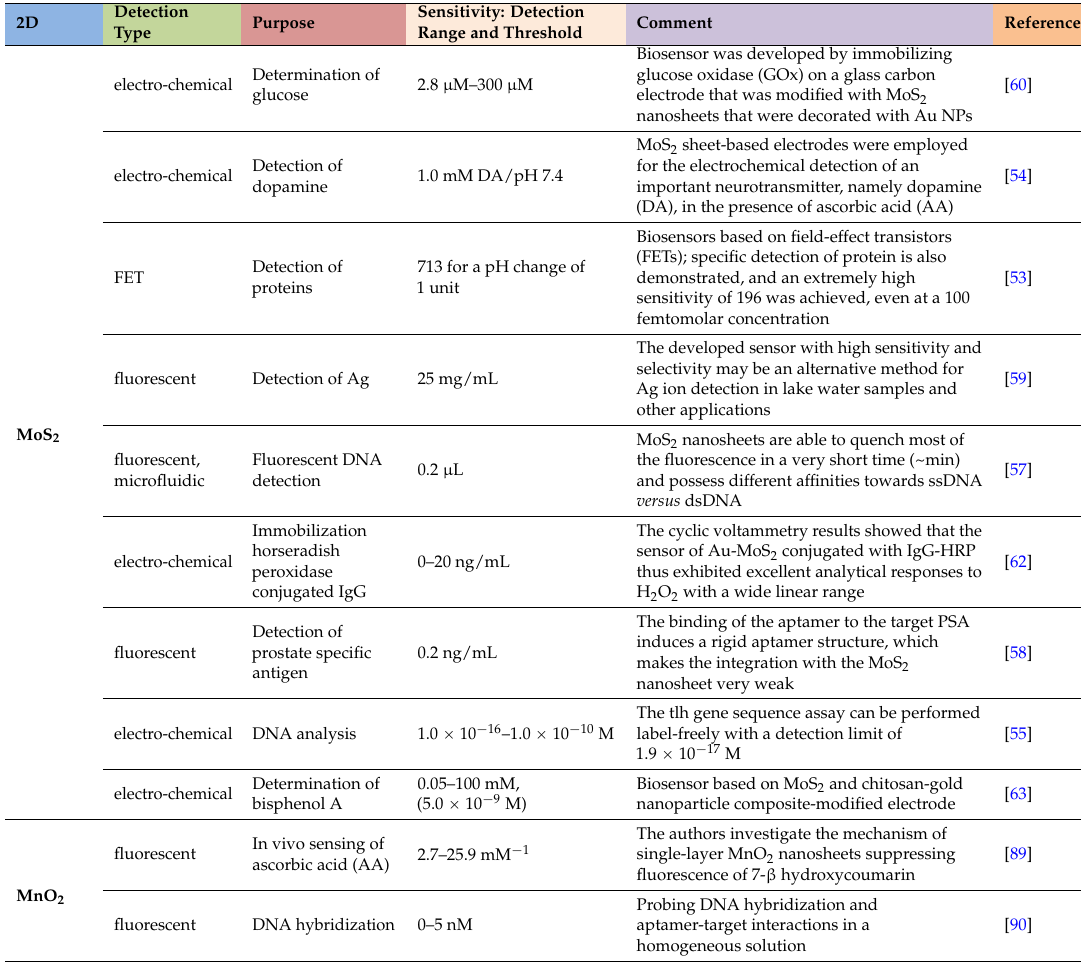
Table 1. Example of non-graphene 2D materials’ application in different types of biosensors